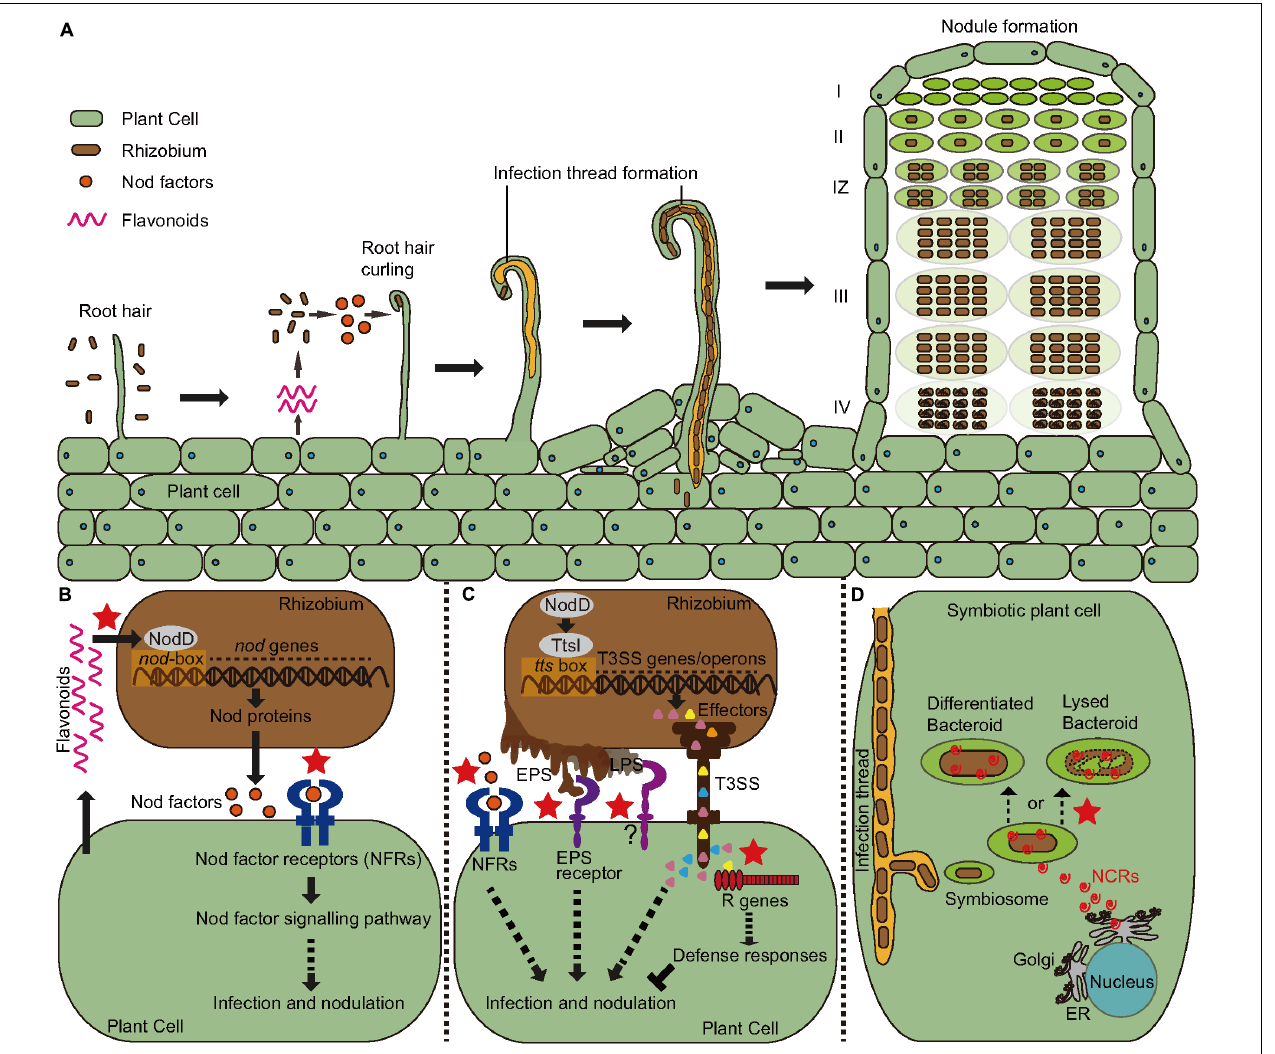
FIGURE 1 | Symbiosis signaling and plant immunity involved in recognition specificity in the legume-rhizobial interactions (indicated by the red stars). (A) The process of infection and nodule development. A mature indeterminate nodule contains a meristem zone (I), an infection zone (II), an interzone (IZ), a nitrogen fixing zone (III), and a senescent zone (IV). (B) The host secretes flavonoids to induce the expression of bacterial nodulation ( nod ) gene through the activation of NodD proteins. The enzymes encoded by the nod genes lead to the synthesis of Nod factors (NF) that are recognized by host Nod factor receptors (NFRs). Recognition specificity occurs both between Flavonoids and NodDs and between NF and NFRs. (C) In addition to NF signaling, bacteria also produce extracellular polysaccharides (EPS) and type III effectors to facilitate their infection in compatible interactions, but these molecules may also induce immune responses causing resistance to infection in incompatible interactions. (D) Certain legumes such as Medicago encode antimicrobial nodule-specific cysteine-rich (NCR) peptides to drive their bacterial partners to terminal differentiation that is required for nitrogen fixation. However, some rhizobial strains cannot survive the antibacterial activity of certain peptide isoforms, leading to formation of nodules defective in nitrogen